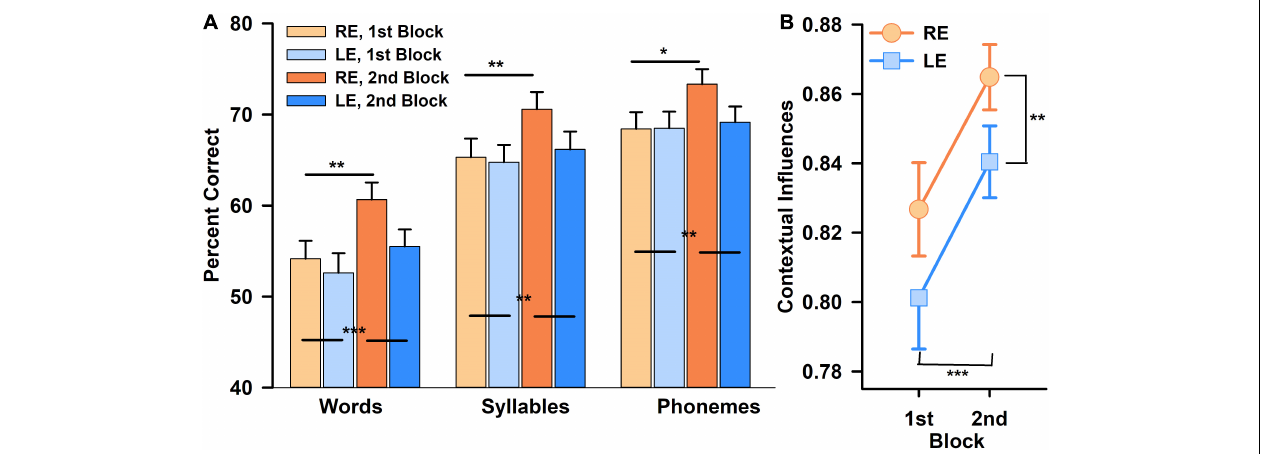
FIGURE 2 | Percent correct scores obtained in speech perception task (left panel), for the right ear (RE, orange) and the left ear (LE, blue), for each block (first block in light colors, second block in darker colors). Percent scores were calculated in words, syllables, and phonemes (A) . Contextual influences (j − 3 ) obtained for RE (orange) and LE (blue) for each block. The closer the index (j − 3 ) is to 1, the greater the contextual influences are (B) . Statistically significant differences are mentioned as stars after correction for multiple tests (* p < 0.05; ** p < 0.01; *** p <